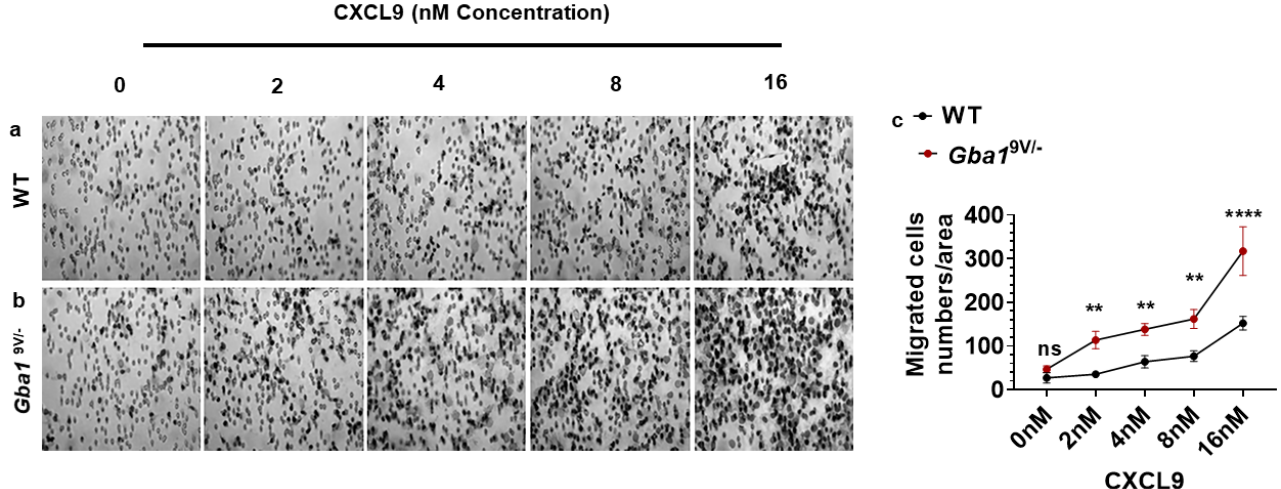
Figure 3. CXCL9 drives dose-dependent increased chemotaxis of T cell subsets in Gba1 9V/ − mice. Spleen-derived CD4 + T cells from WT and Gba1 9V/ − mice ( n = 5/group) were allowed to migrate towards different concentrations of CXCL9 (0, 2, 4, 8, and 16 nM) at 37 ◦ C and 5% CO 2 for 45 min. The migration membrane was removed and stained with Diff-Quick and cells were counted under the light microscope. Diff quick- images and the corresponding bar diagrams represent the CXCL9 induced T cells migration in WT ( a – c ) and Gba1 9V/ − mice ( b , c ). WT (black curve), Gba1 9V/ − (maroon curve) and values shown are the mean ± SD. and group comparison were performed with ANOVA (ns, not significant; **, p < 0.01; ****, p <